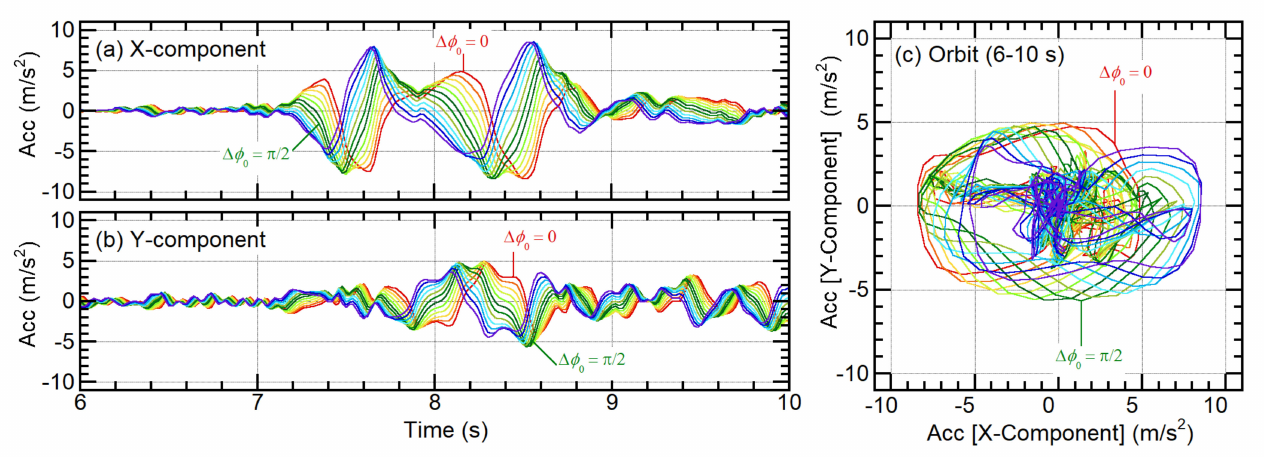
Figure A2. Comparisons of the time-history and orbit of phase-shifted ground motions